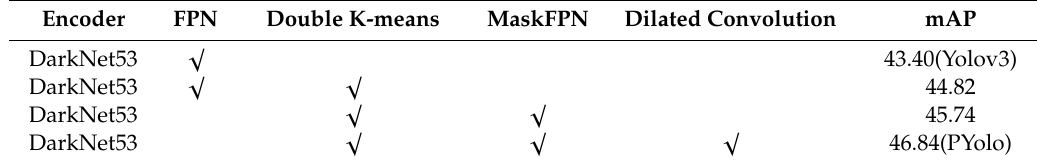
Table 6. Impact of improvements on PYolo (%).